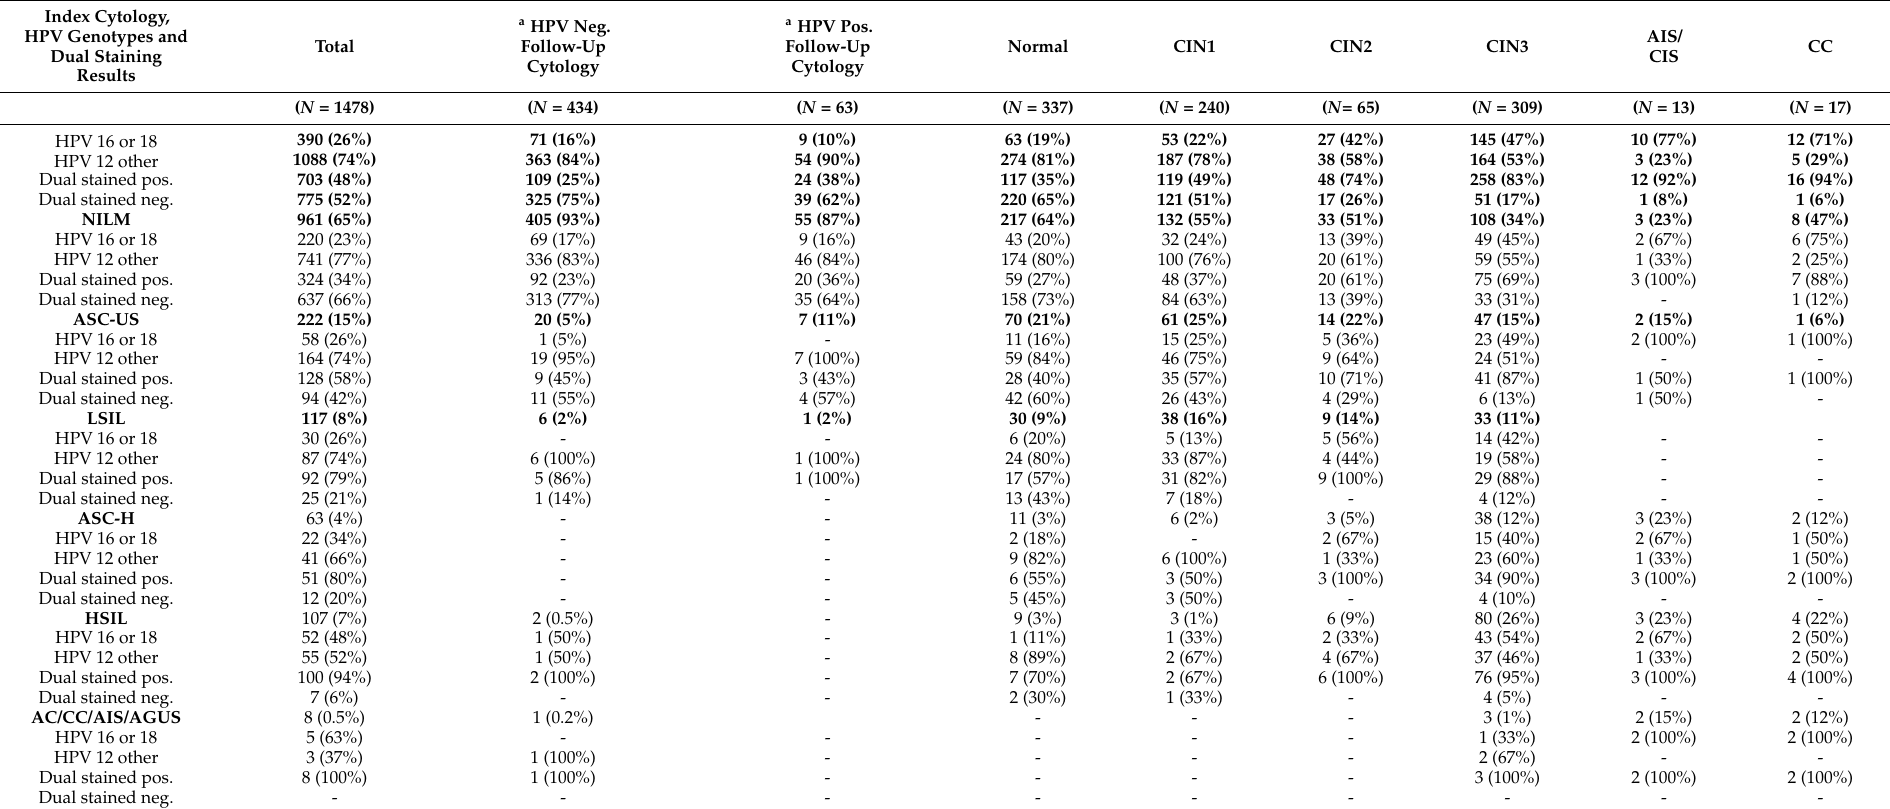
Table 1. Cervical cytology results, partial HPV genotyping, and p16/Ki-67 dual staining results in baseline cytology and follow-up with either HPV negative